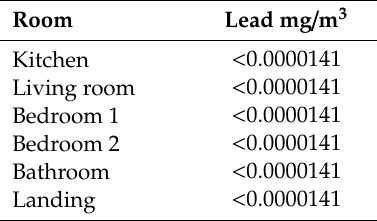
Table 4. Lead measurement in the indoor environment (TLV-TWA 0.05 mg / m 3